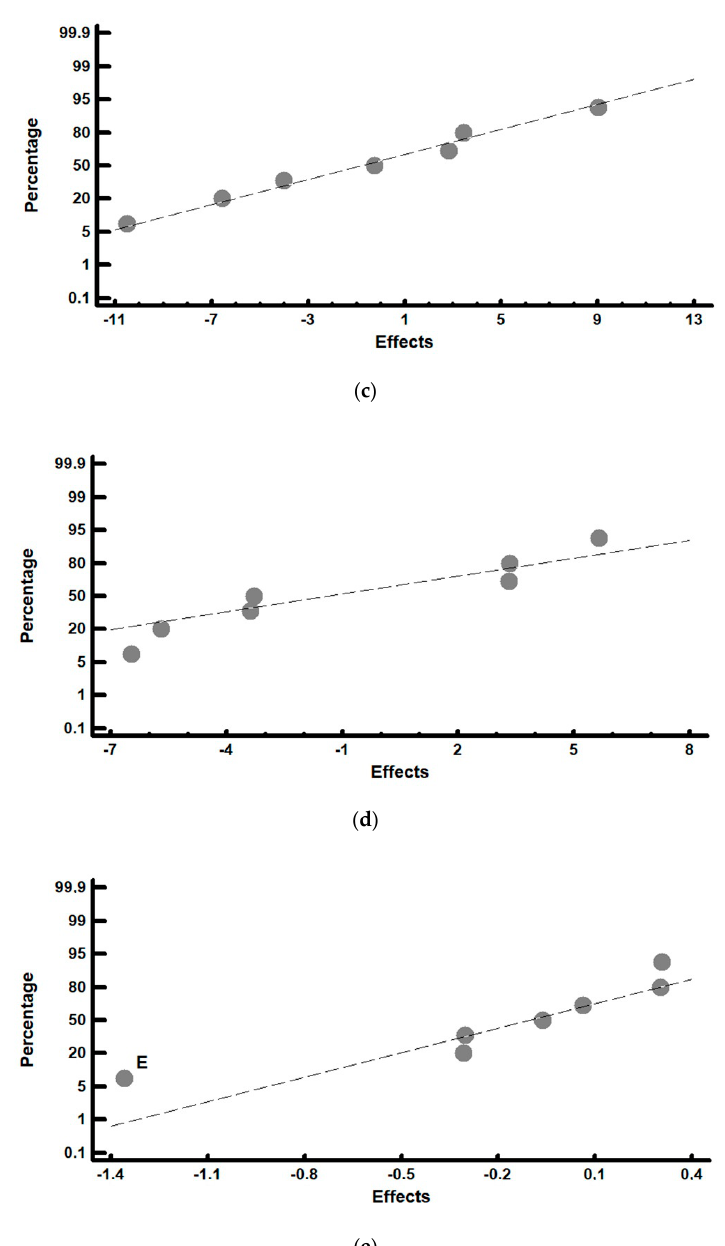
Figure 6. Representation of the effects on the percentages by weight of the precipitated phases on a normal probability plot. Those factors with a significant effect are highlighted. ( a ) tempered martensite; ( b ) austenite; ( c ) K 2 carbides; ( d ) K 1 carbides; ( e ) Fe 3 C.